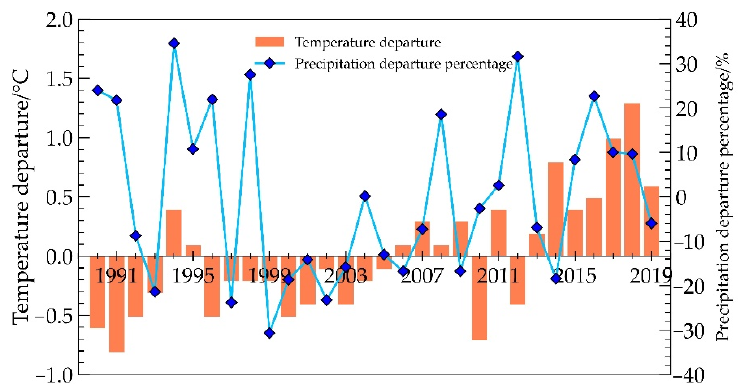
Figure 2. Relationship between the percentage of temperature anomaly and precipitation anomaly in Beijing.